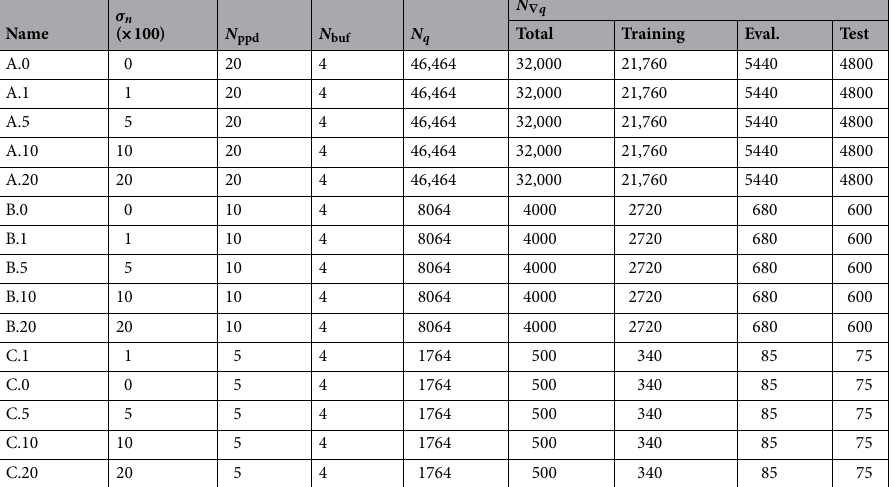
Figure 4. Single regularization result: regularization results for the dataset B.10, with N ppd 0.1 . Top panels: histograms of the relative error distribution of the regularised and unregularised flux σ n = function (left) and each gradient component (next three panels), respectively (see legend for details). The blue shaded regions correspond to the regularised error distribution expanded by a factor 10. Bottom panels: corresponding cumulative error distributions for the histograms in the top panels, particularly the regularised and unregularised flux function data (blue and red) and its individual gradient components (green and olive),